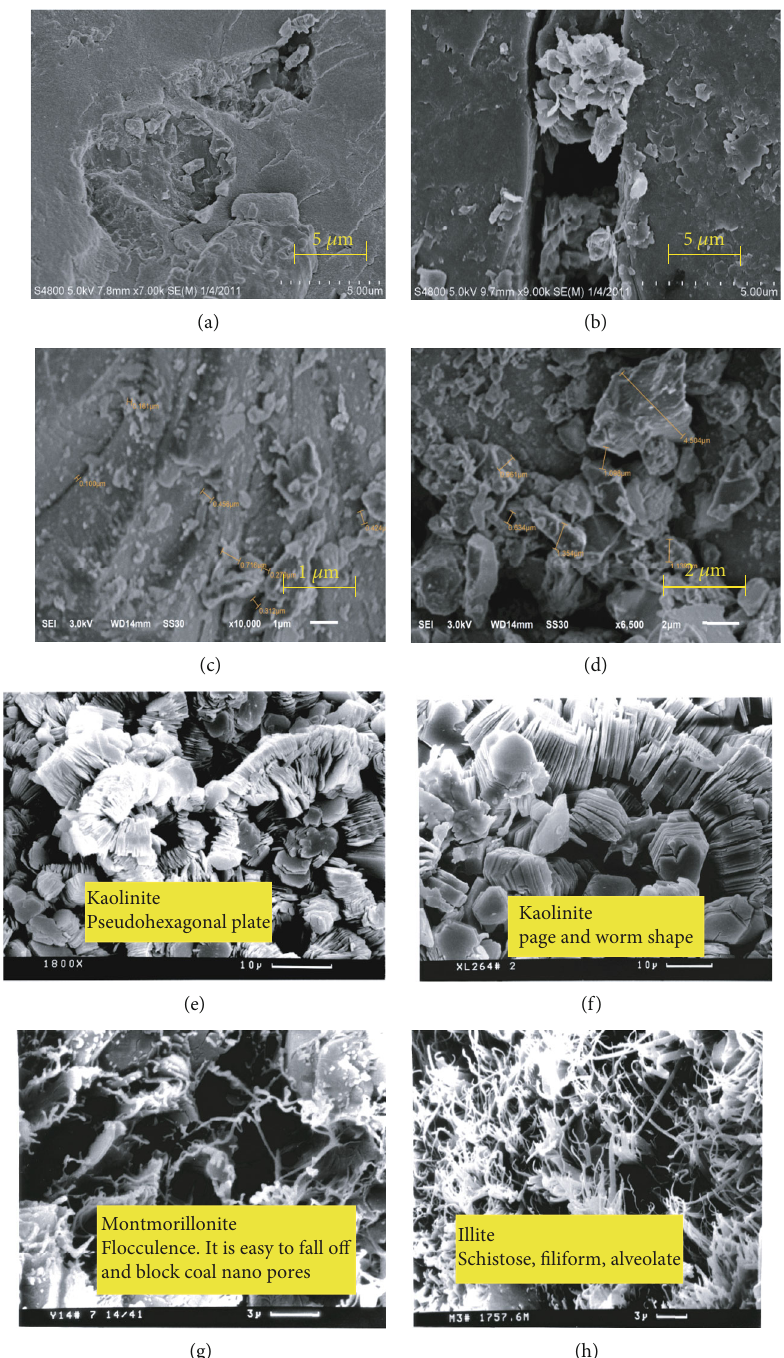
Figure 2: Electron microscope images of the coal